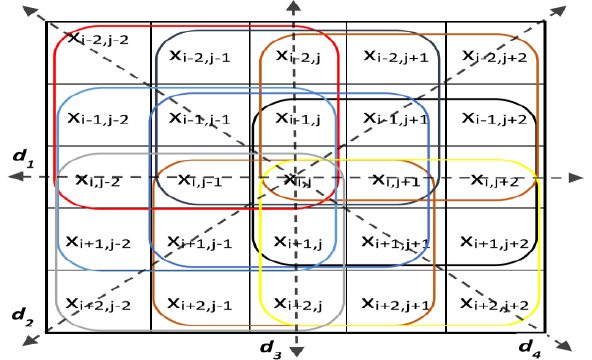
Figure 3. A large window of size 5 × 5 divided into 9 overlapping sub-windows of size 3 × 3 and four edge directions 𝑑 1 , 𝑑 2 , 𝑑 3 , 𝑑 4 [38].